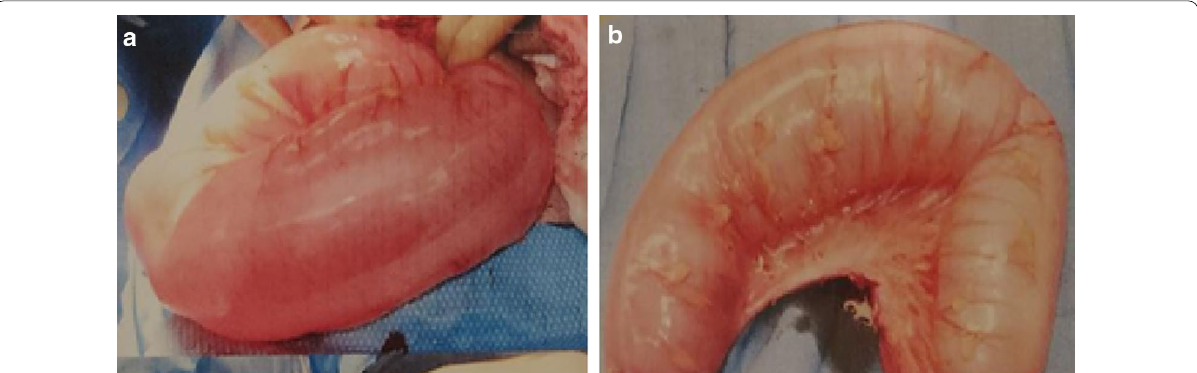
Fig. 2 Intraoperative images of excised sigmoid colon. a Image taken from prior to resection. b Image taken after resection. Note the distended bowel which spans the entire width of the